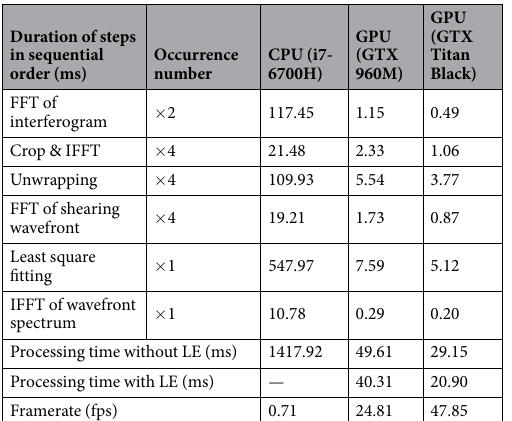
Table 1. Framerate comparison between different processors. The process steps are listed in the sequential order corresponding to the flowchart in Fig. 3, and their occurrence numbers indicate the times each process step occurs in the phase retrieval algorithm. Note that the duration of the second FFT on the 501 × 501 shearing wavefront was a bit larger than that of the first FFT on the 2048 × 2048 interferogram on GPU platforms, due to the fact that the zero padding of 501 × 501 pixels to the size of 2 N for FFT also consumes time in memory